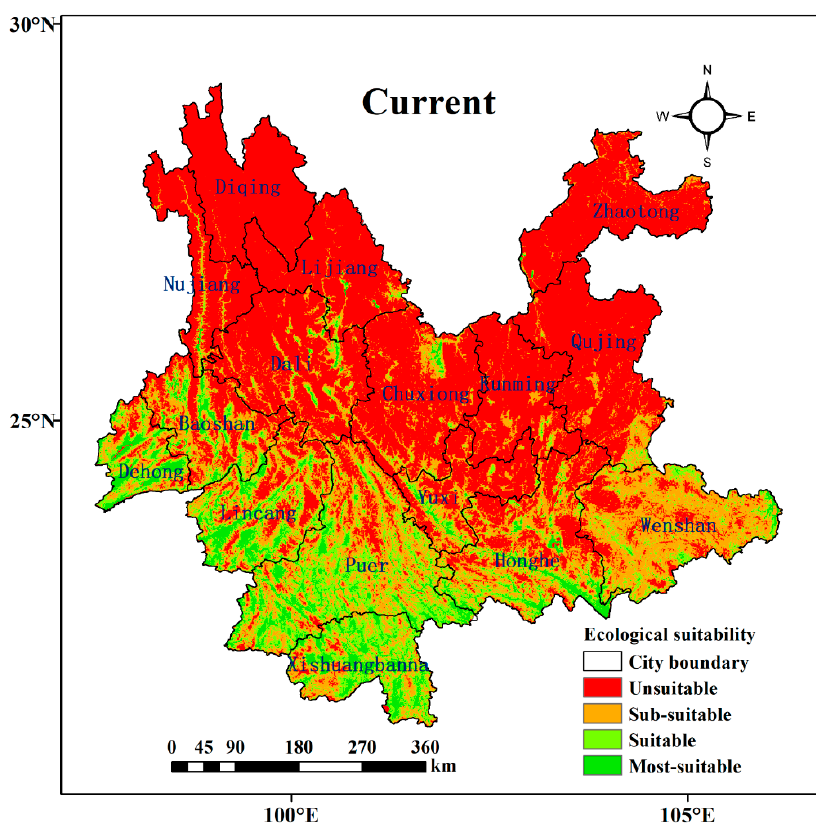
Figure 5. Map of ecologically suitable areas for Arabica coffee at present. Table 2. Percentage contribution and ranked importance of environmental variables in the Max- ent